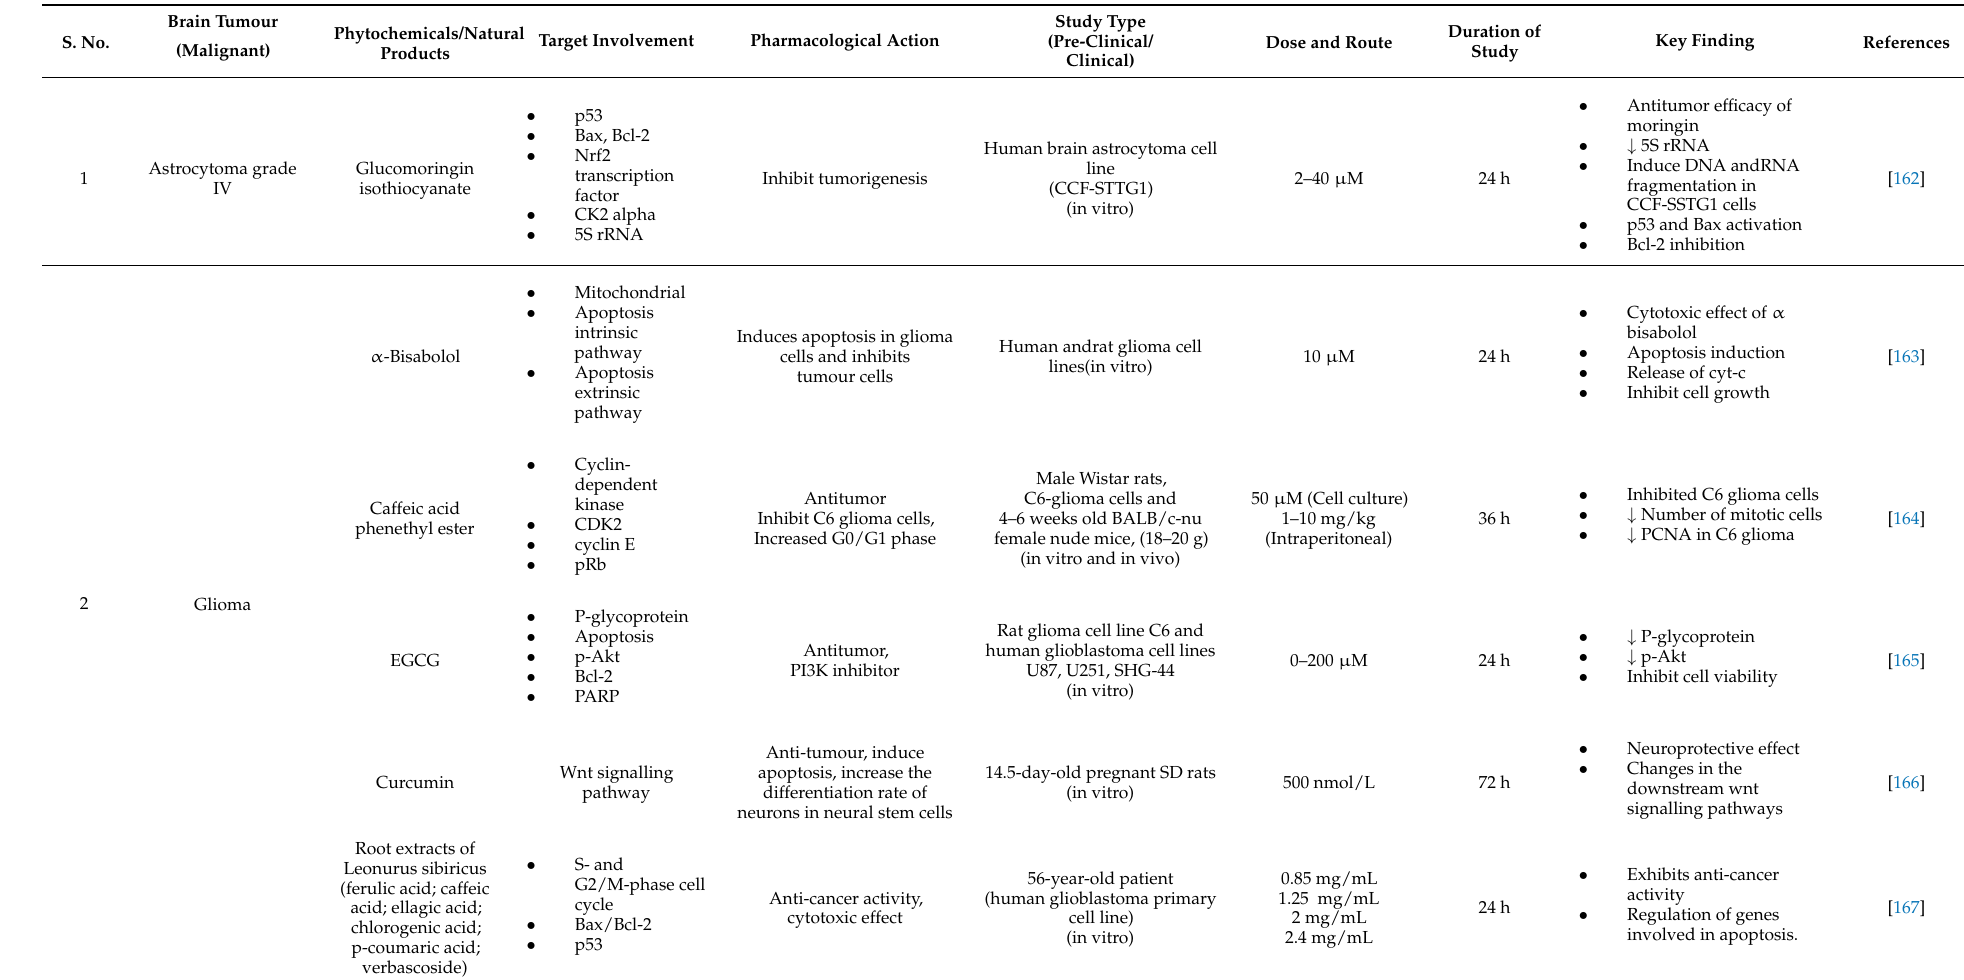
Table 2. Summarised nano-based phytochemicals/natural products in malignant brain tumours. S.